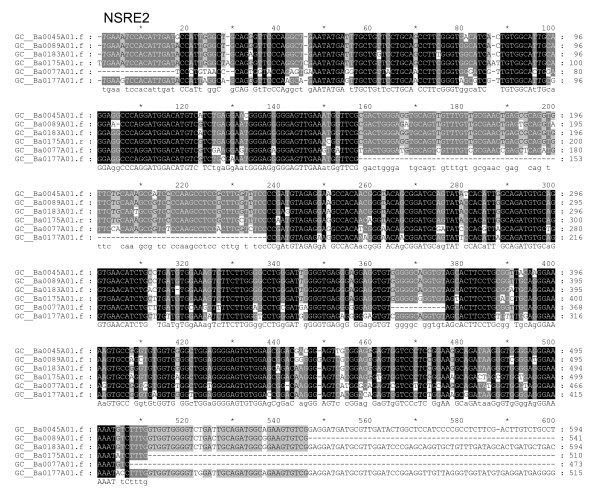
NSRE2 analysis. NSRE2 full-length BES sequences were aligned using ClustalW. Shaded color correlates the degree of nucleotide conservation (e.g. black; identical in all sequence). Consensus sequences are shown under the alignment in lower cases.